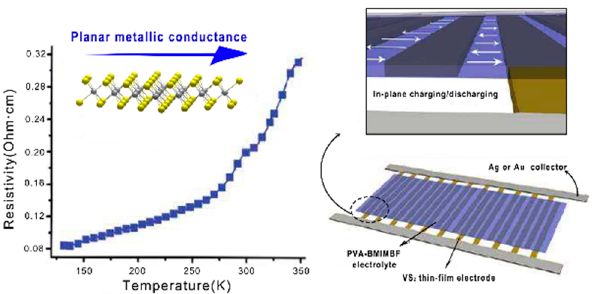
Figure 4. VS 2 as a new type of high performance in-plane supercapacitor based on quasi 2D materials. Reproduced from [70], with the permission of the American Chemical Society.